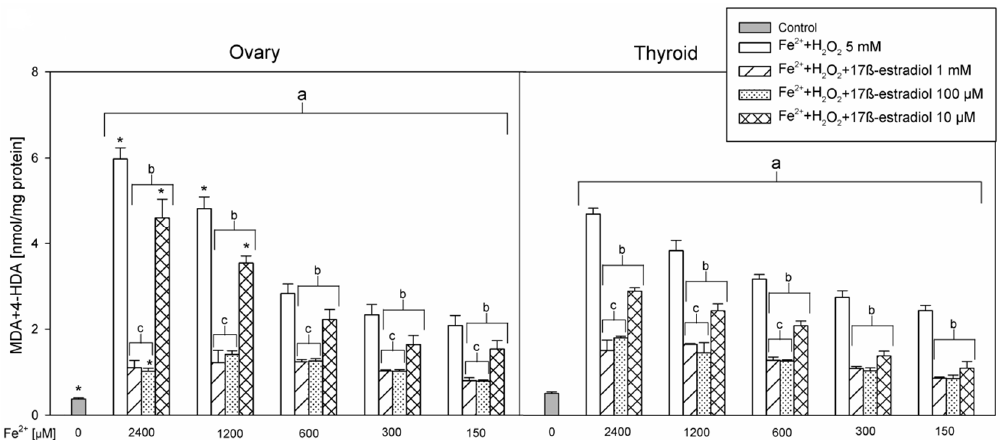
Figure 1. The concentrations of malondialdehyde + 4-hydroxyalkenals (MDA+4-HDA) in porcine ovary and thyroid homogenates. Homogenates were incubated in the presence of FeSO 4 (2400, 120, 600, 300, and 150 µM) plus H 2 O 2 (5 mM) used to induce lipid peroxidation and, additionally, in the presence of 17β-estradiol (1 mM; 100, 10.0, 1.0 µM; 100, 10.0, 1.0 nM; 100, 10.0, 1.0 pM). Only four concentrations of 17β-estradiol are presented in Figure 1, as other concentrations revealed exactly the same effects as the concentration of 1 µM. Data are expressed as the amount of MDA+4-HDA (nmol) per mg of protein. Bars represent the mean ± SE of three independent experiments run in duplicates. a p < 0.05 vs. control ‘0’ in the same tissue; b p < 0.05 vs. respective concentration of Fe 2+ (+H 2 O 2 ) without 17β-estradiol; c p < 0.05 vs. respective concentration of Fe 2+ (+H 2 O 2 ) + 17β-estradiol 10 µM; * p < 0.05 vs. the same substance/concentration in the other tissue.